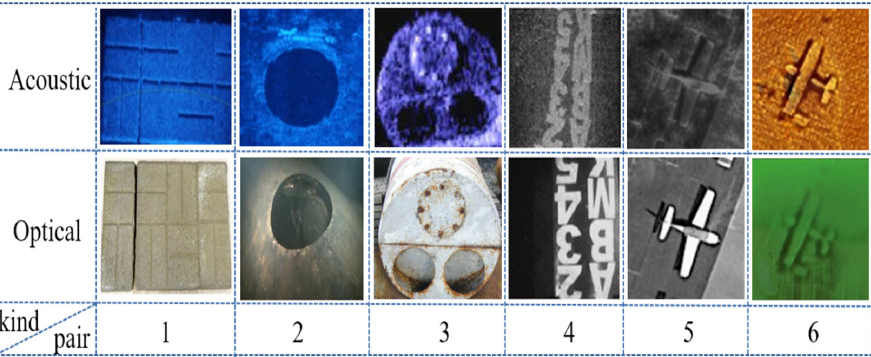
Figure 7. The test samples set: ( 1 ) paver bricks, affine transformation; ( 2 ) a hatch, affine transformation; ( 3 ) a mine shape, affine transformation; ( 4 ) a letter string, affine transformation; ( 5 ) plane, DIDSON style; ( 6 ) plane, SSS and underwater optical style.